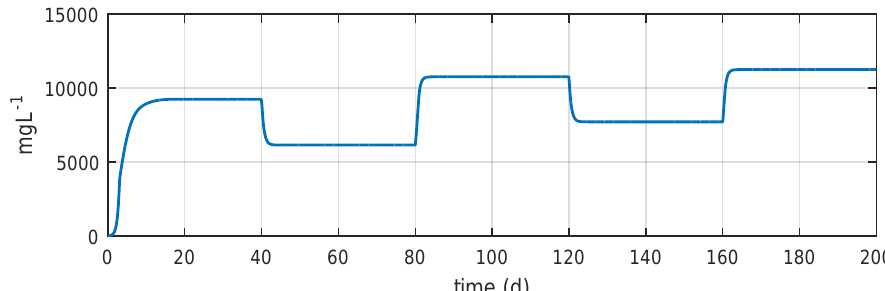
Figure 18. Anodophilic biomass concentration x a in the MEC.